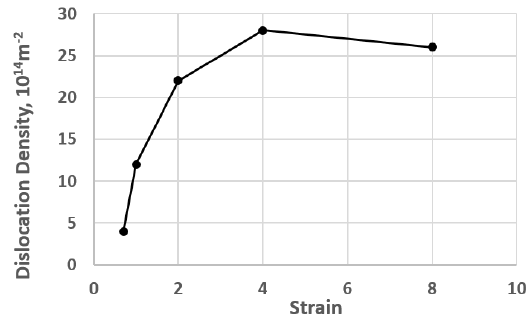
Figure 6. Example of cold-sprayed copper particle impact.